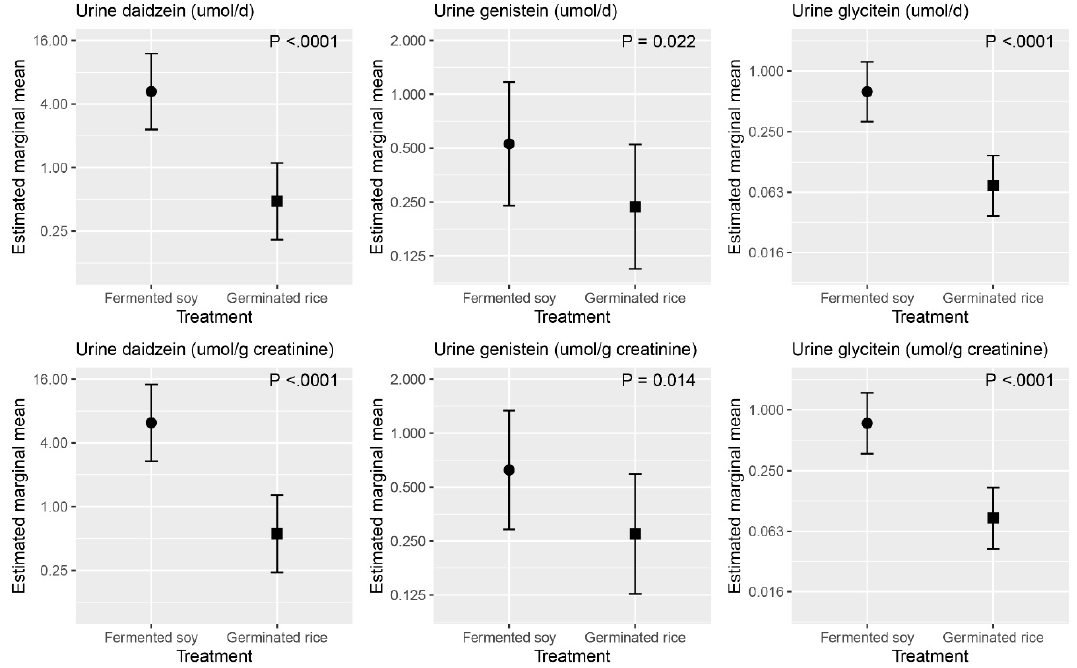
Figure 3. Estimated marginal means for the 24 h urine excretion of isoflavones (daidzein, genistein, glycitein) following the fermented soy and germinated rice intervention. Note: The y axis on a log 10 scale.